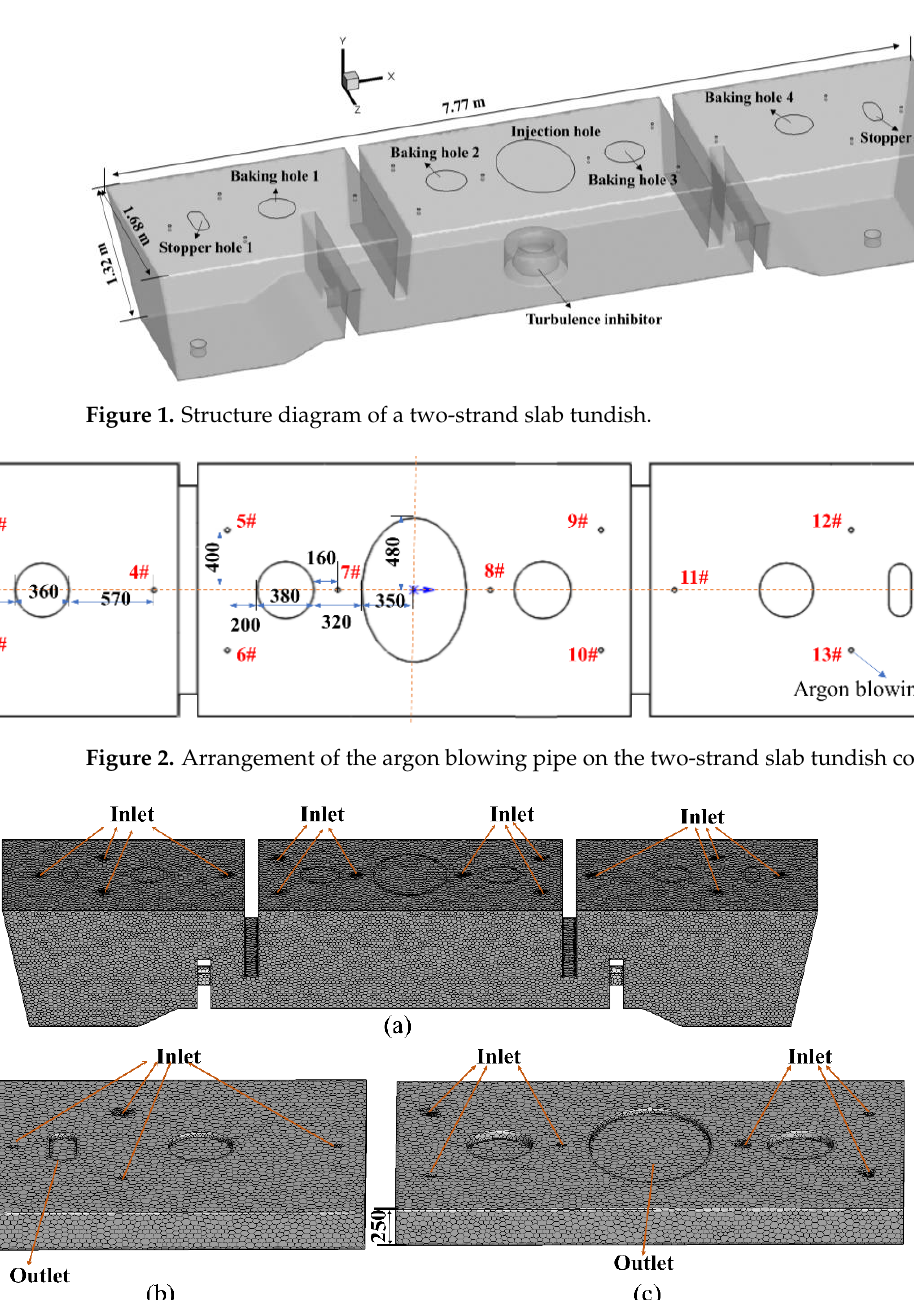
Figure 3. Mesh for empty tundish ( a ), isolated casting chamber ( b ), and isolated injecting chamber ( c ) (mm).